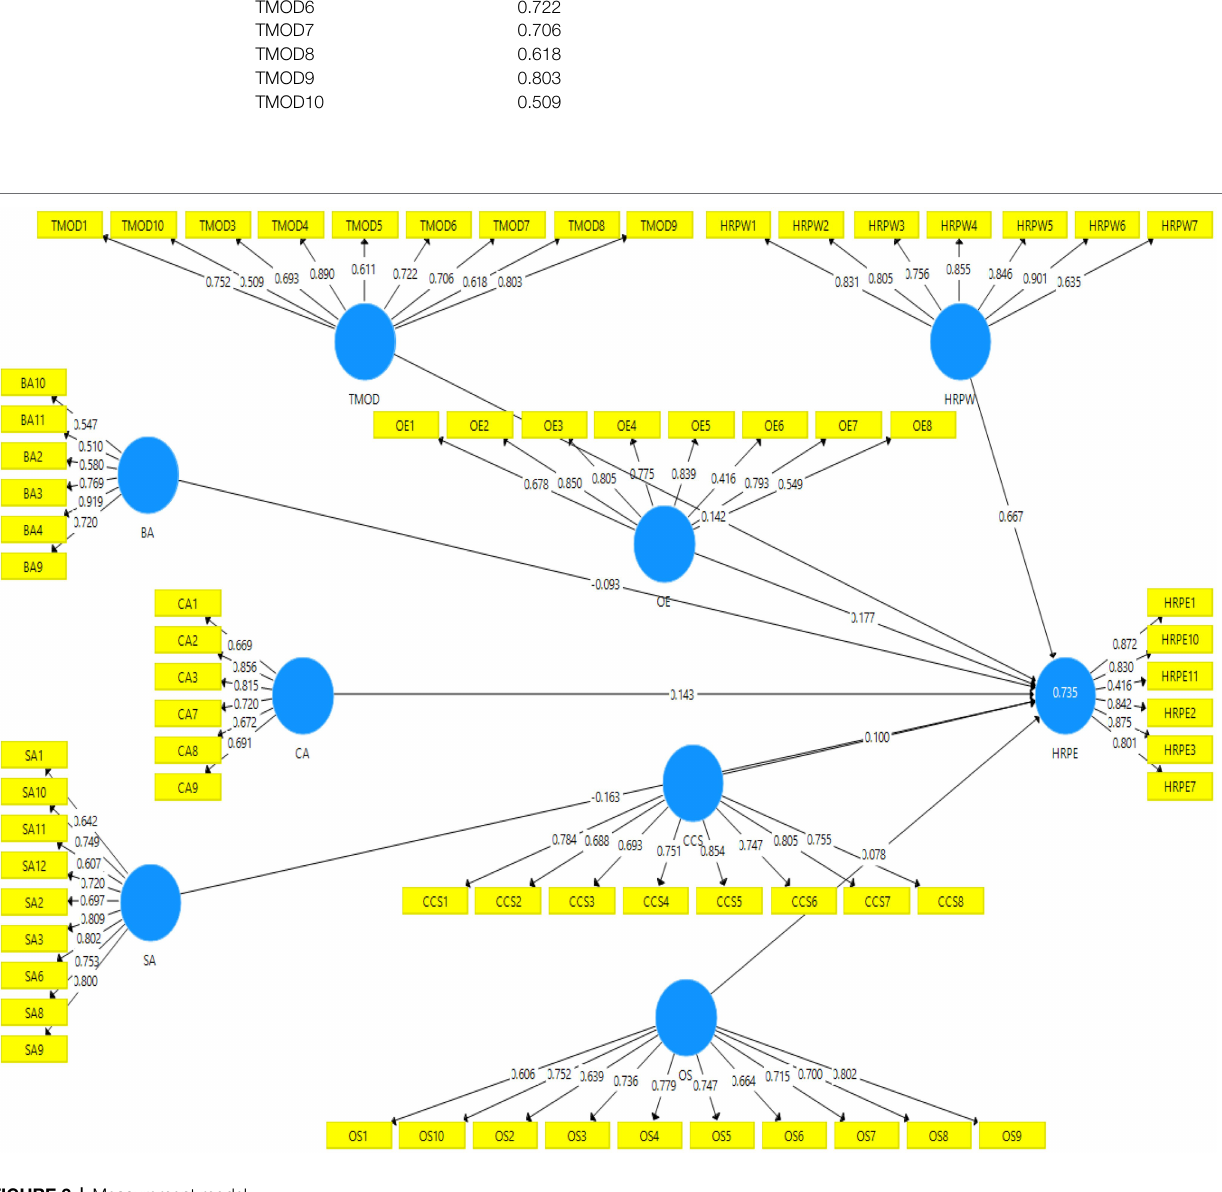
FIGURE 2 | Measurement